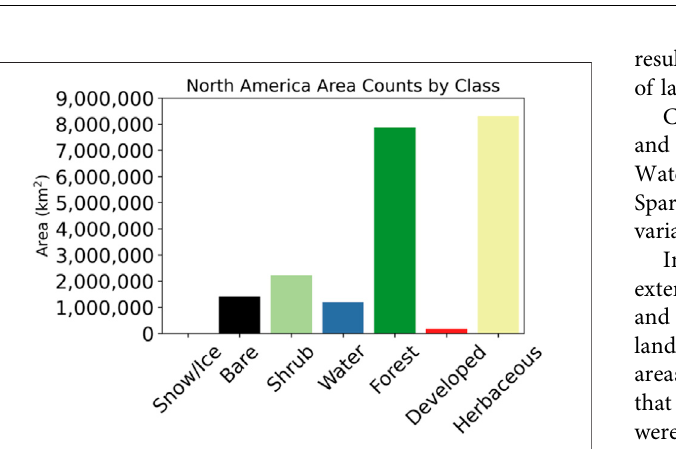
Frontiers in Remote Sensing |